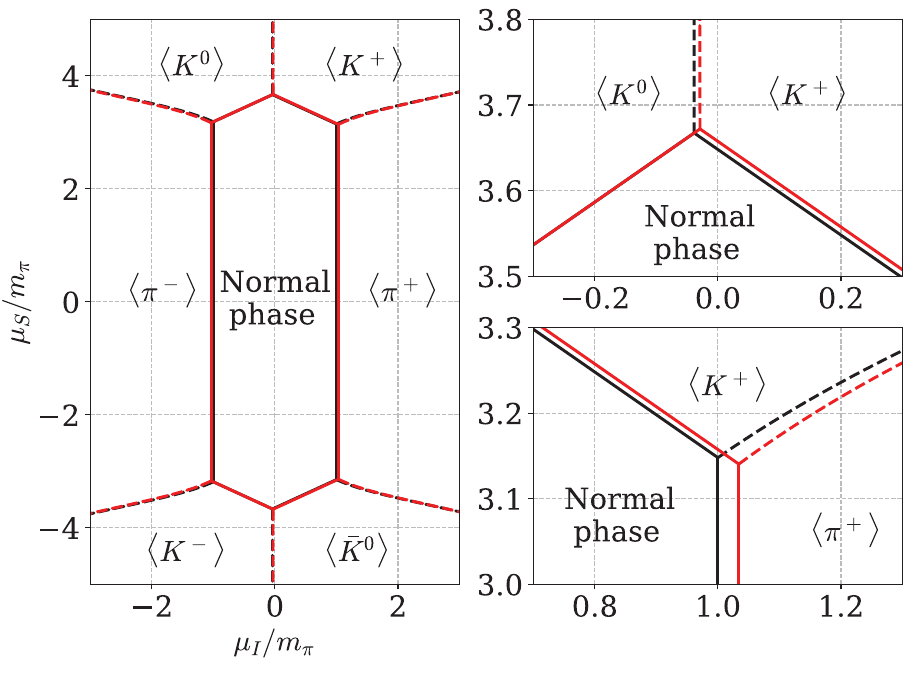
Figure 3. Left panel shows the phase diagram as predicted by χ PT in the μ I – μ S -plane. In the right panel, we have zoomed in on the triple points. See main text for details. Fig. from Ref.